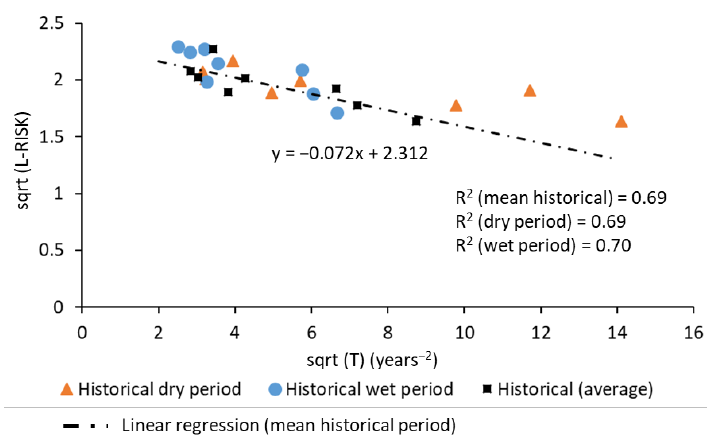
Figure 7. Relationship between the target and explanatory variables for the best linear regression √ √ L − RISK = a × T + b model ( √𝐿 − 𝑅𝐼𝑆𝐾 = 𝑎 × √𝑇 + 𝑏 ). model (